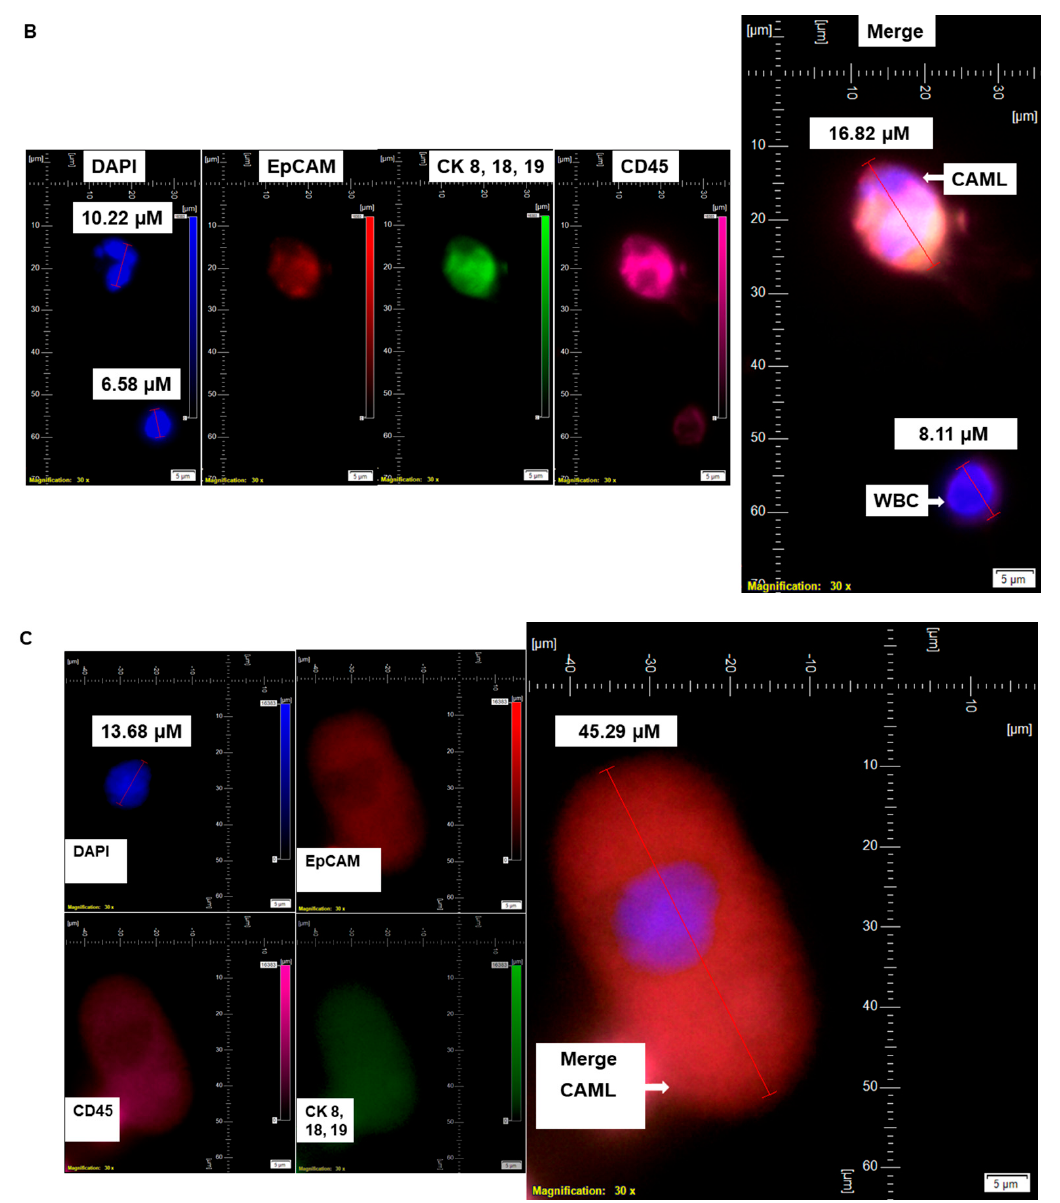
Figure 1. Identification of CD45 + /CK 8,18,19 + /EpCAM + CAMLs and their size-based types in the blood of patients with endometrial cancers: Representative pictures of a typical CAML ( A ), a tiny CAML of 16.82 µM ( B ), and a giant CAML of 45.29 µM ( C ) in three patients with endometrial can- cers, as enumerated by a CD45-Cy5/CK 8,18,19-FITC/EpCAM-PE immuno-fluorescence kit. WBCs are CD45 + /CK 8,18,19 - /EpCAM - /DAPI + . Pictures were taken with a 60 X oil objective using an Olym- pus IX71 microscope with DAPI/FITC/PE/CY5 filter sets. Cells were captured on a microfilter and stained with a CellSieve enumeration kit (Creatv Microtech) with DAPI/CK-FITC/EpCAM- PE/CD45-Cy5. The magnification, scale bar, and digital reticle are represented for each photomicro- graph. Fluorescence images from the DAPI, FITC, TRITC and Cy5 channels were separated as pic- tures with a color bar. The fluorescence photomicrographs present the diameters (µm) of a CTC and a representative WBC and their respective DAPI-stained nuclei.